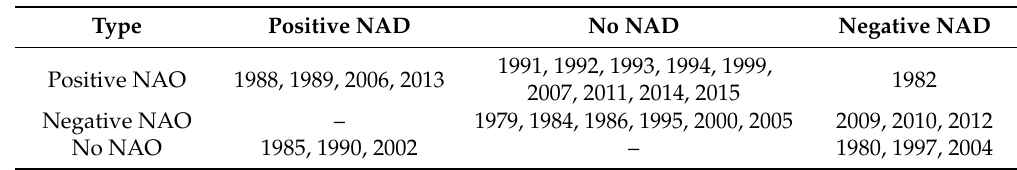
Table 1. Classification of years in which positive (negative) NAD events are or are not simultaneous with a positive (negative) NAO event during the period 1979–2016 (see text for the definition of the NAD and NAO events).